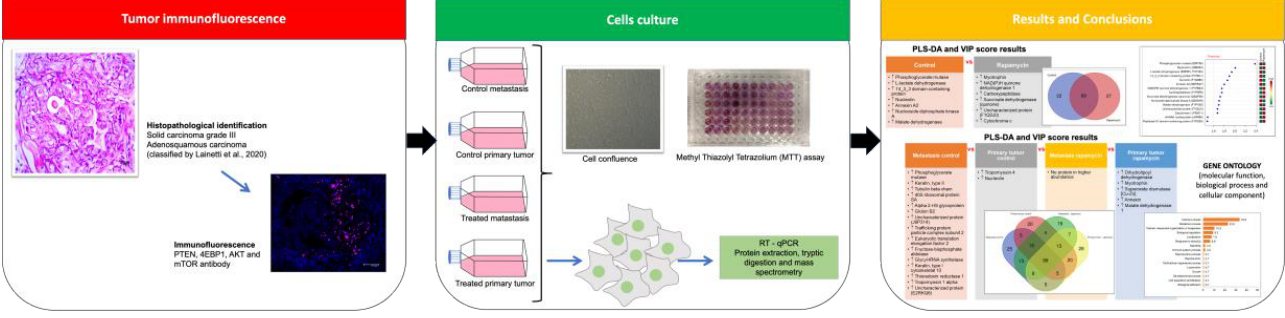
Figure 6. Experimental design.